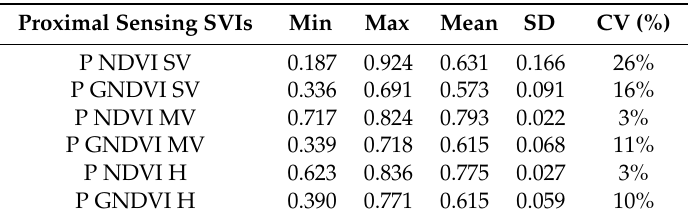
Table 5. Descriptive statistics of the proximal-based spectral vegetation indices at different crop stages for the three years.